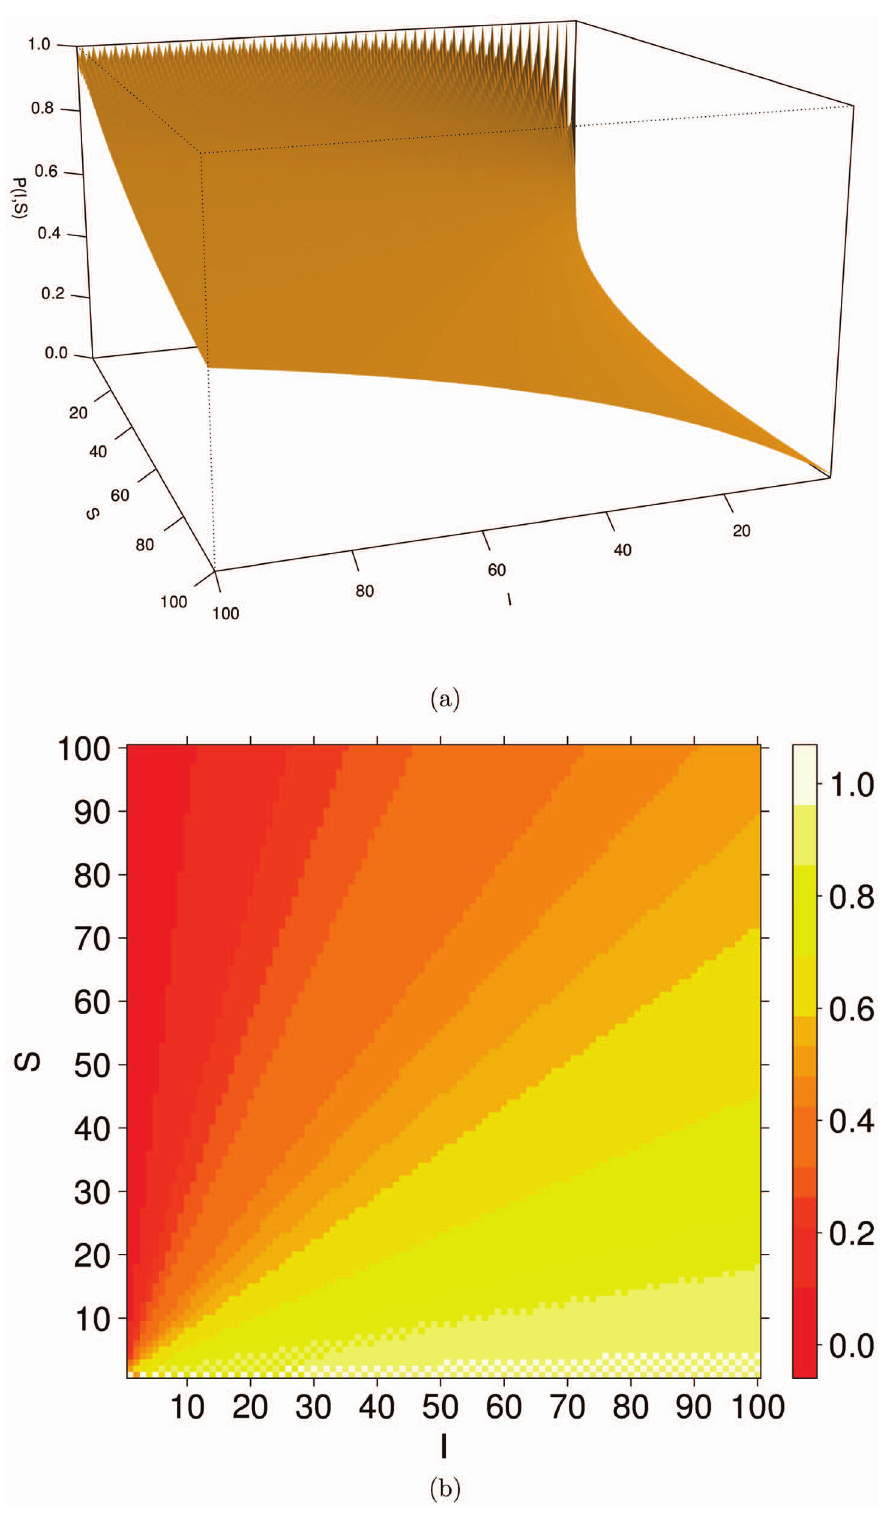
Figure 5. Tridimensional surface (a) and corresponding levelplot (b) of P ( I , S ) for 1 ƒ I , S ƒ 100 , linearly interpolated on the real non integer values.